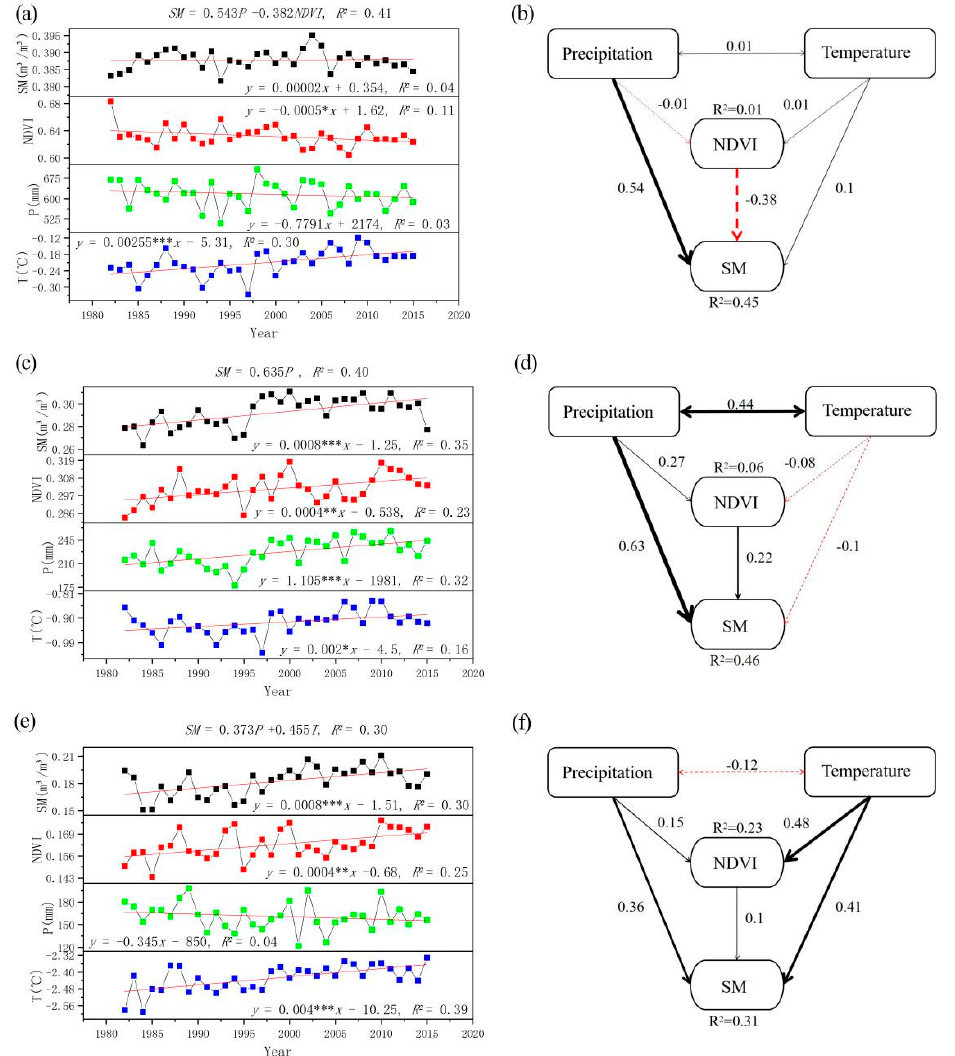
Figure 5. Interannual variation of annual mean precipitation (P), temperature (T), NDVI, and SM in ( a ) humid, ( c ) semi-arid, and ( e ) arid regions of the Tibetan Plateau from 1982 to 2015. ***, **, * represents significance levels of 0.001, 0.01, 0.05; stepwise regression equations for SM are shown at the top of ( a , c , e ). ( b , d , f ) are the results of structural equation modeling of the relationship between NDVI, precipitation, temperature, and SM.